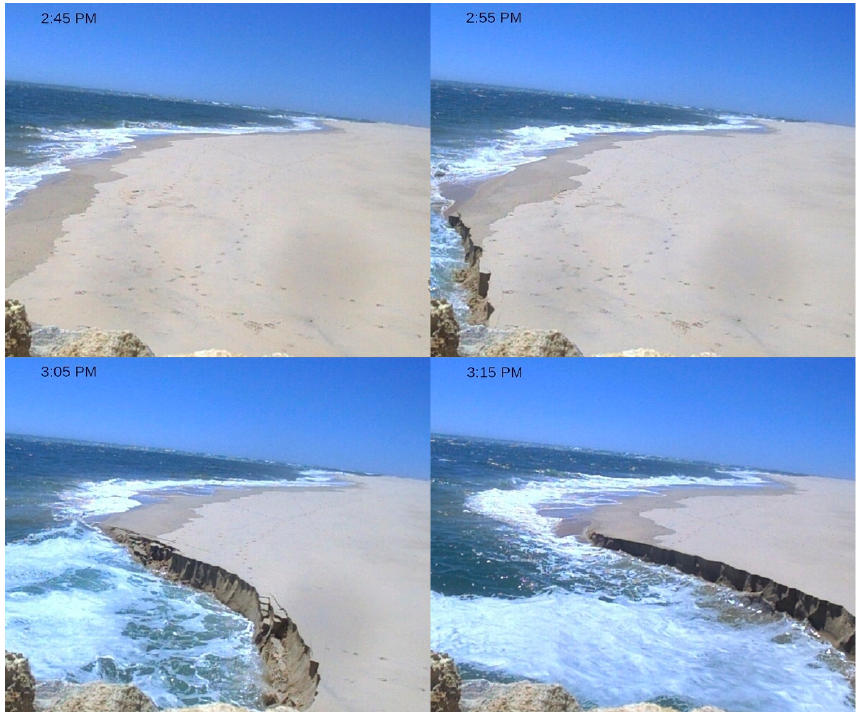
Figure 13. Beach collapse at Cap Ferret, dated June 2016. Time stamps 14:45, 14:55, 15:05 and 15:15. Photo: Nédélec.